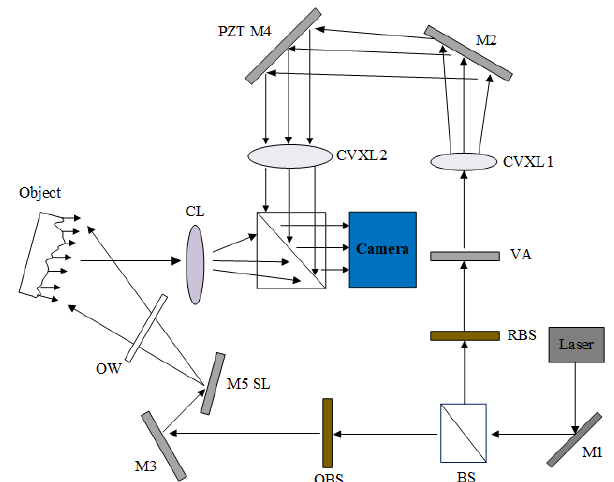
Figure 1. The schematic of the digital holographic speckle pattern interferometry (DHSPI) system redrawn from [13]: BS, beam splitter; OBS, object beam shutter; RBS, reference beam shutter; VA, variable attenuator; CVX, convex; L, lenses; M, mirrors; SL, surface lens; OW, optical window; PZT, piezoelectric transducer.